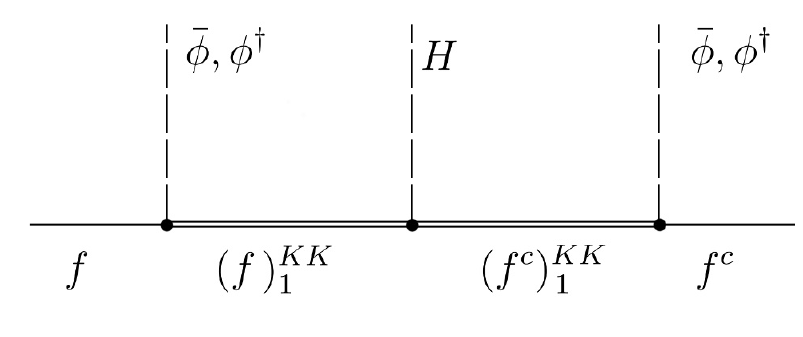
Figure 1 . Diagram that generates the e(cid:11)ective Yukawa terms mediated by KK